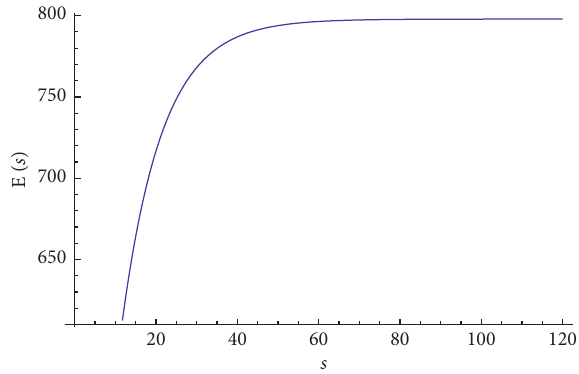
Figure 2: Evolution trend of enterprise pollutant production e under different regulations.